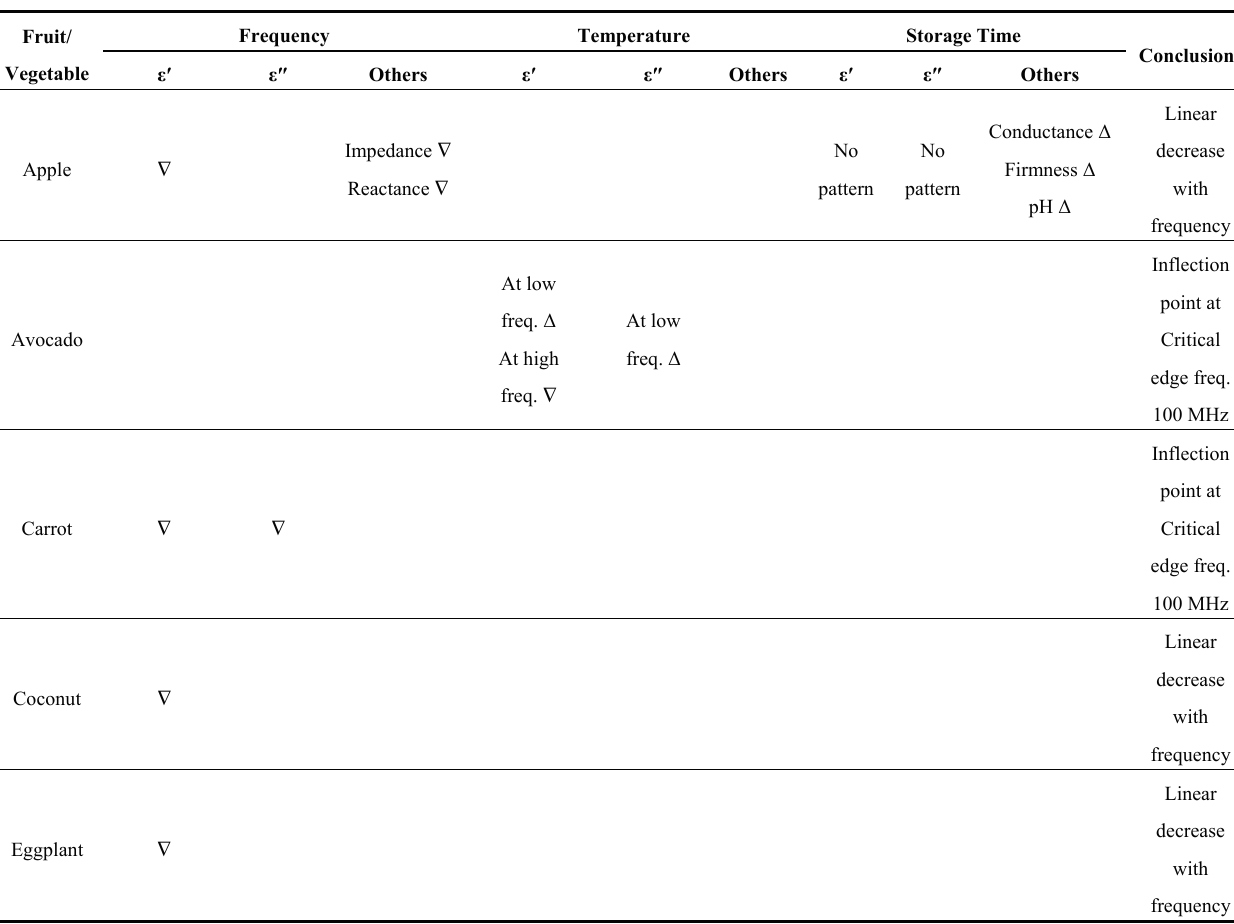
Table 3. Parameter Variation overview ( Δ & ∇ for parameter increases and decreases,